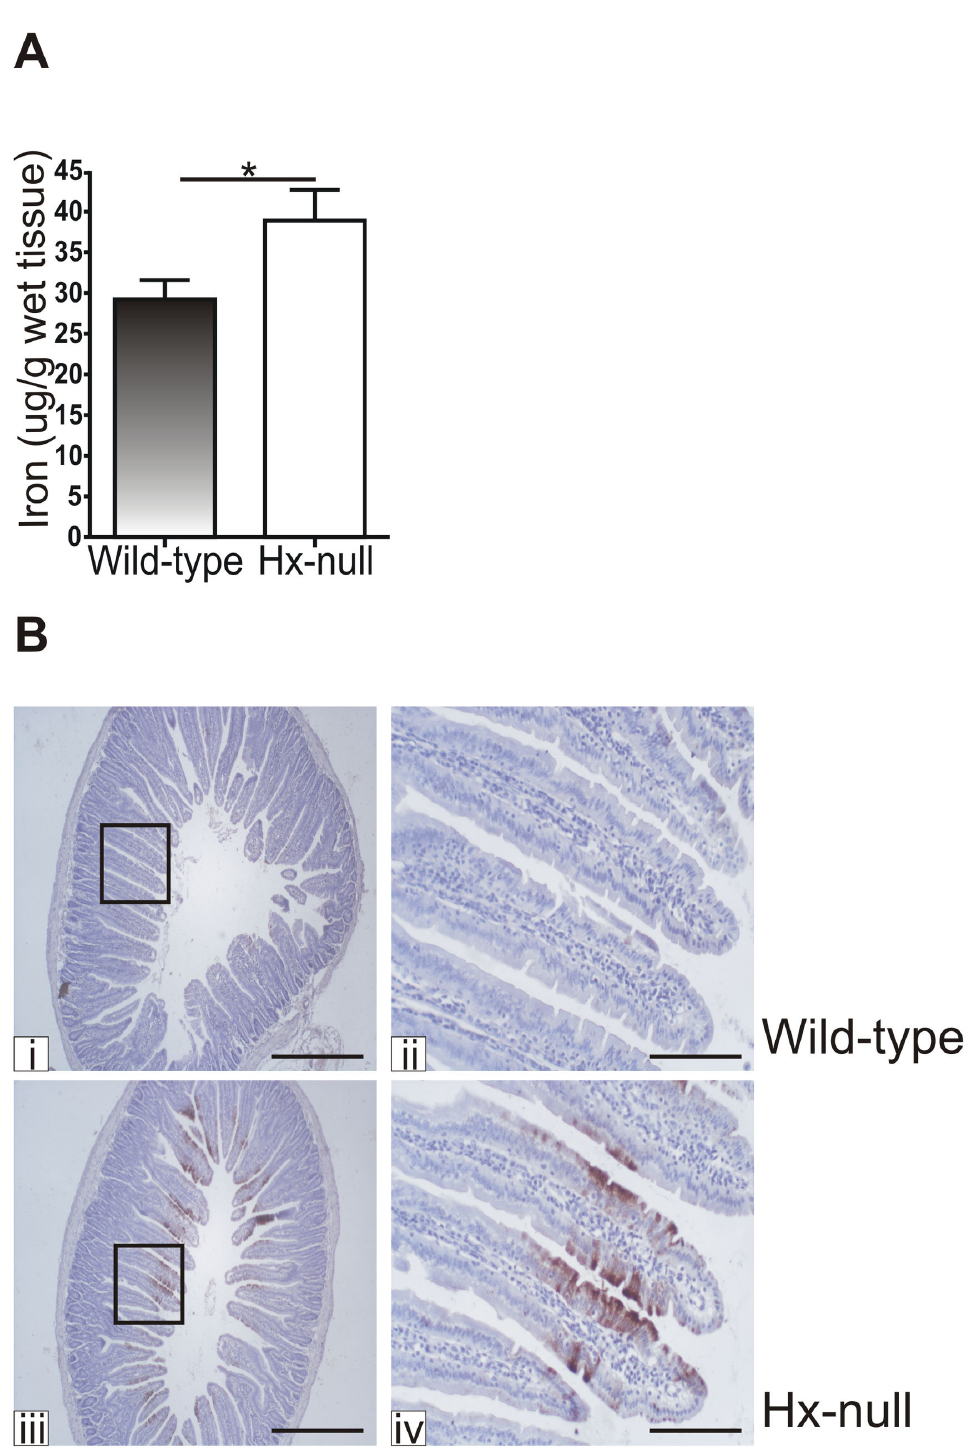
Figure 1. Hx deficiency results in increased iron deposits in the duodenum. (A) Total iron content in the duodenum of 2 month-old wild-type and Hx-null mice measured by ICP-MS. Values are expressed as μg iron/g wet tissue. Data represent mean ± SEM; n=10; * = P<0.05. (B) Duodenal sections of a wild-type mouse (i, ii) and an Hx-null mouse (iii, iv) at 2 months of age stained with DAB enhanced Perls’ reaction. Note the more intense staining in the duodenum of the Hx-null mouse. Bar i, iii = 500µm; bar ii, iv = 100µm. doi: 10.1371/journal.pone.0068146.g001 PLOS ONE |